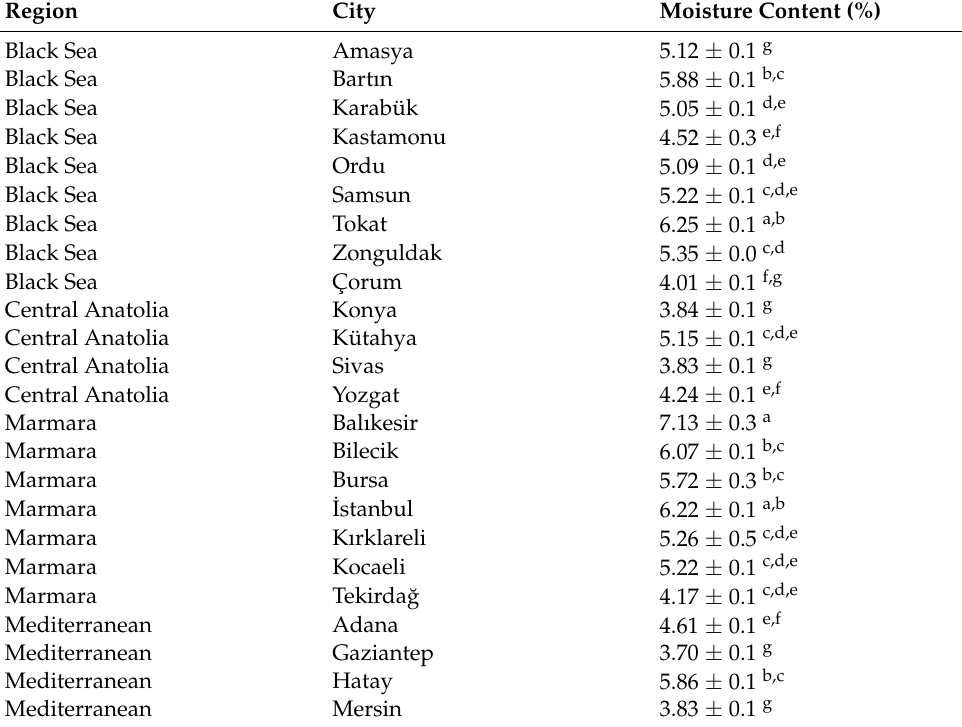
Table 1. Moisture content (%) of Anatolian propolis samples (data are expressed as g water/100 g of the crude